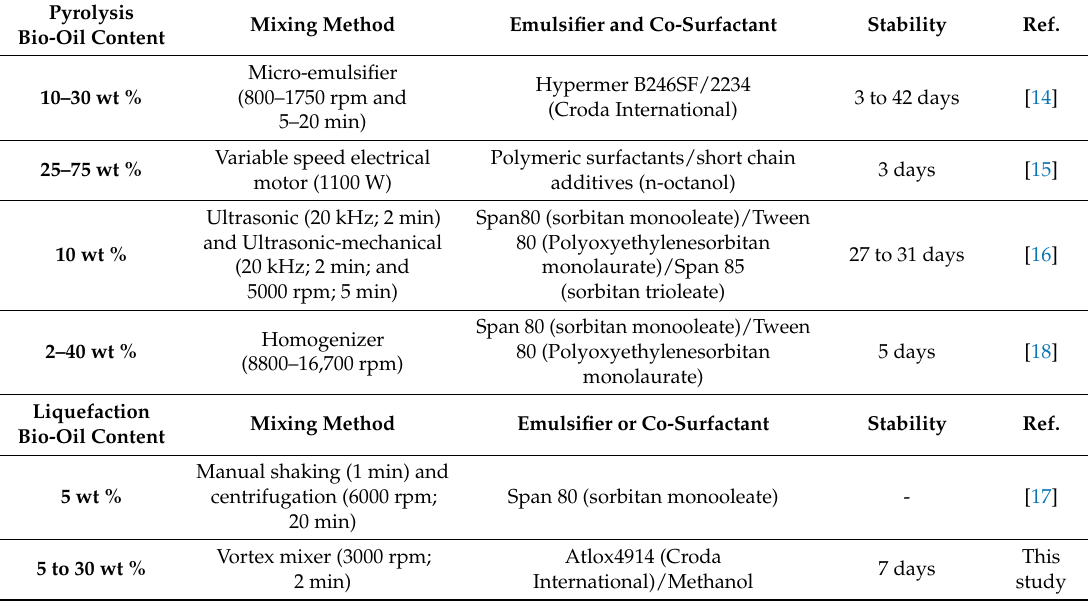
Table 1. Literature of bio-oil and liquefaction oil in diesel